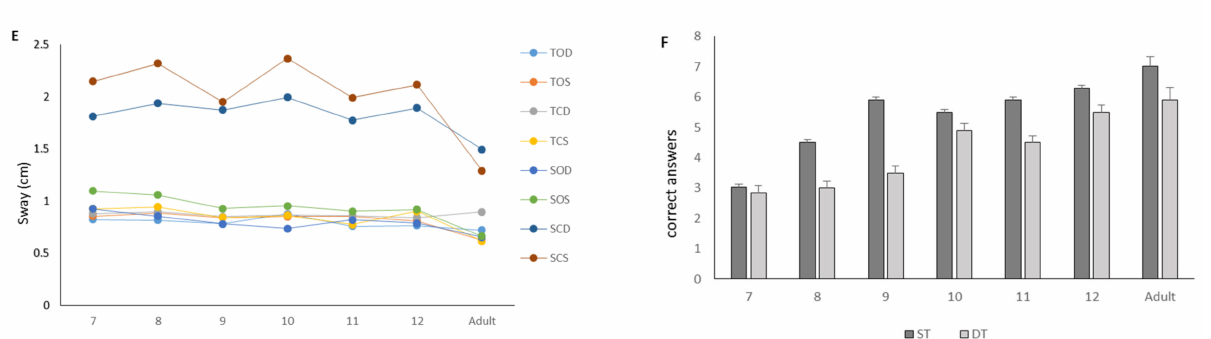
Figure 1. ( A ) Interaction of age and gender with the visual factor. ( B ) Interaction of age and gender with the factor of base of support. ( C ) Interaction of age and gender with the task factor. ( D ) Interaction of age and gender with the direction factor. ( E ) Comparison of PS at different ages while performing different tasks. ( F ) Comparison of cognitive function between ST and